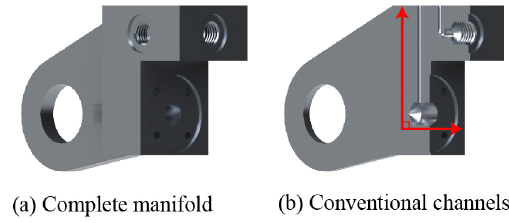
Figure 5. Original manifold